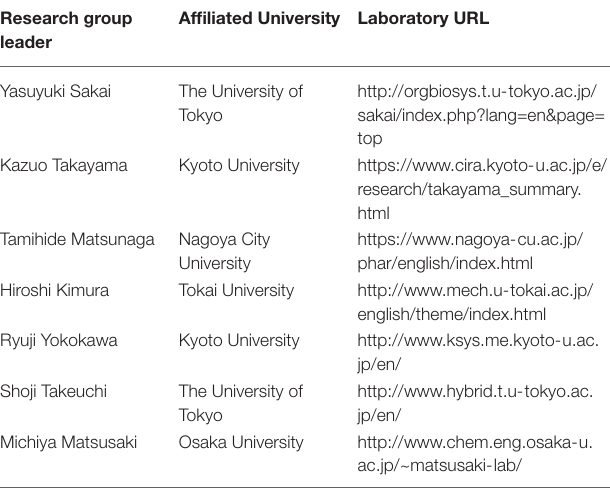
TABLE 1 | List of Laboratories participating Program 2 in AMED-MPS